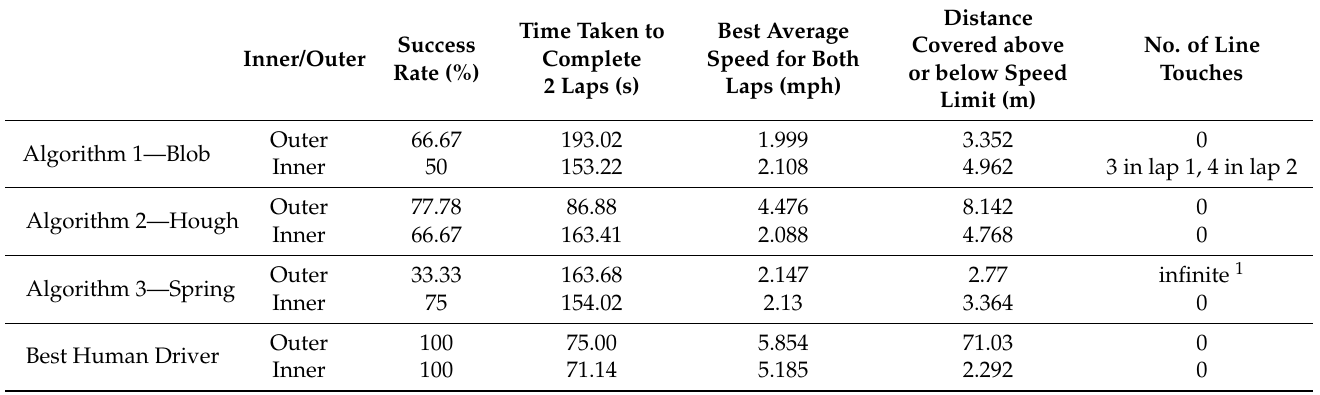
Table 3. Summary of Results